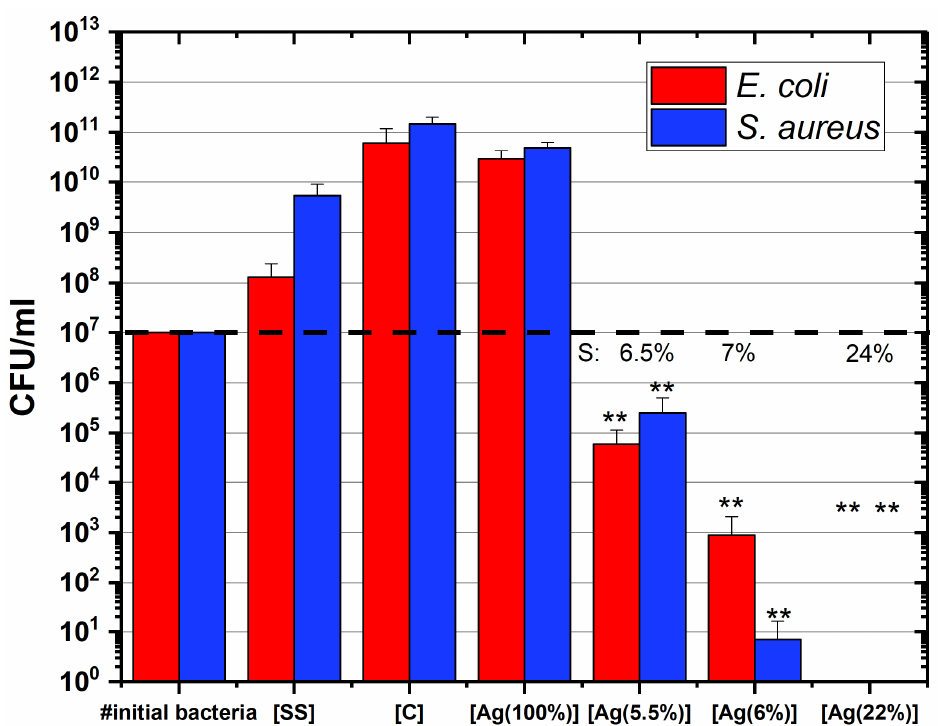
Figure 4. a-C:H:Ag coatings performance evaluated by a CFU method against E. coli (in red) and S. aureus (in blue) bacterial species during an incubation time of 24 h. Data are presented as the mean ± SD ( n = 3). Results of the Mann–Whitney statistical test are shown in the graph (** indicates p < 0.01). [SS] = stainless steel coupons (CTRL); [C] = hydrogenated amorphous carbon coating (CTRL); [Ag(100%)] = coating containing 100% of Ag (CTRL); [Ag(5.5%)] = the carbon matrix contain- ing 5.5% of Ag in the bulk and 6.5% of Ag at the surface; [Ag(6%)] = the carbon matrix containing 6% of Ag in the bulk and 7% of Ag at the surface; [Ag(22%)] = the carbon matrix containing 22% of Ag in the bulk and 24% of Ag at the surface.